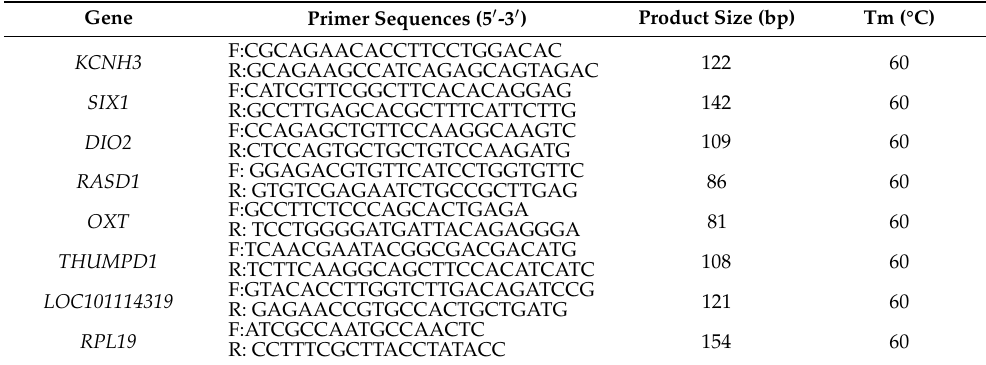
Table 1. The Details of Primers of mRNA.